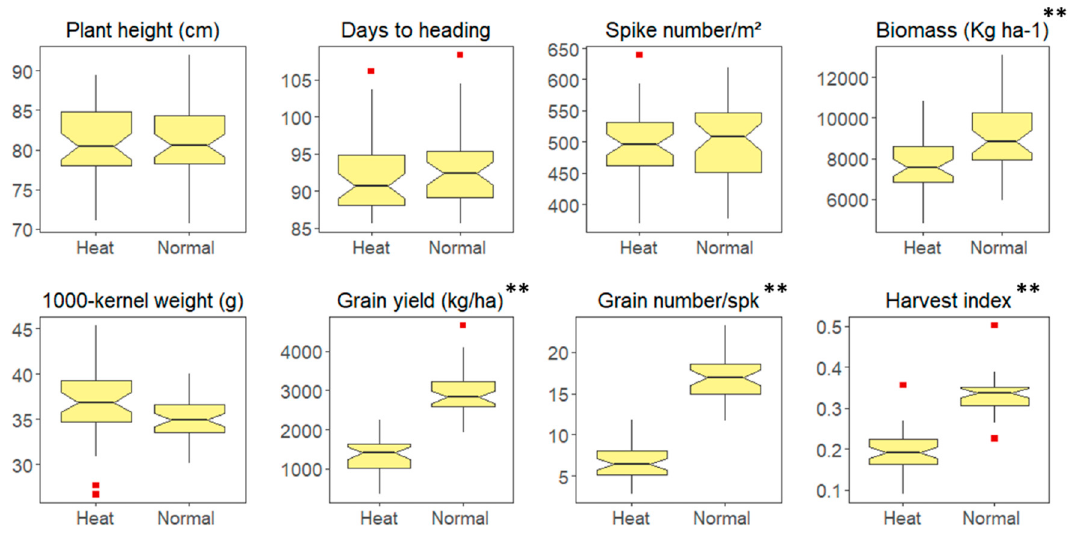
Figure 2. Boxplot of the best linear unbiased estimates (BLUEs) for various traits under two different environmental conditions (Heat: plastic tunnel-mediated heat stress and Normal) across two years. ** indicate significant difference between the means of control and heat-stressed plants at p < 0.05.